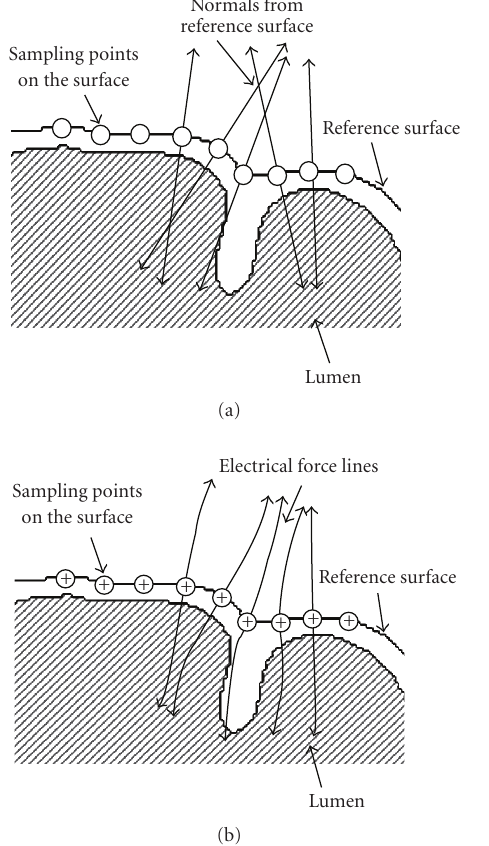
Figure 4: Normals and electrical force lines from sampling points on the reference surface. (a) Normals at di ff erent sample points may intersect, which cause distortions in the eversion, and (b) electrical force lines from sampling points on the reference surface, which are locally orthogonal to the surface but are never in